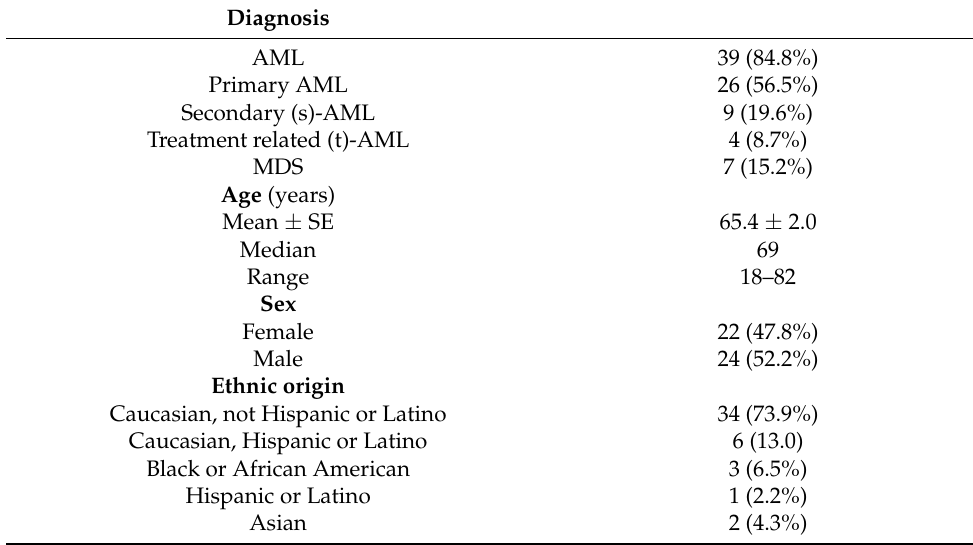
Table 1. Patient characteristics, demographic features, and APVO436 exposure for safety population (N =